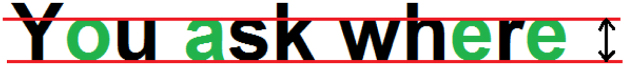
Example of measuring the average height of ‘a’, ‘e’ and ‘o’ from the text. The distance between the top and bottom lines of best fit (red lines) was measured.